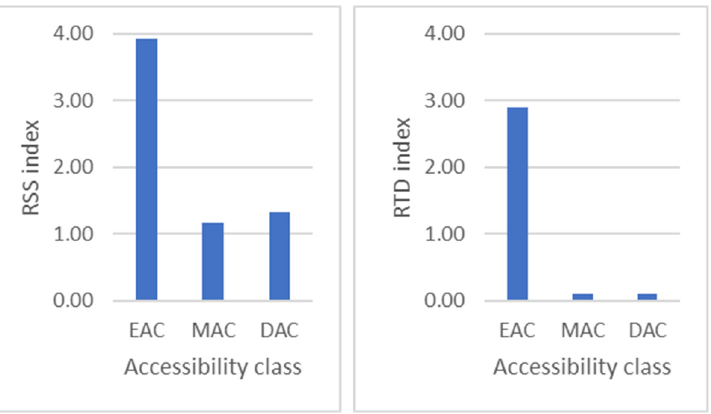
Figure 1. RSS index (Snag volume/living tree volume) and RDT index (Log volume/Standing volume), in the accessibility classes.